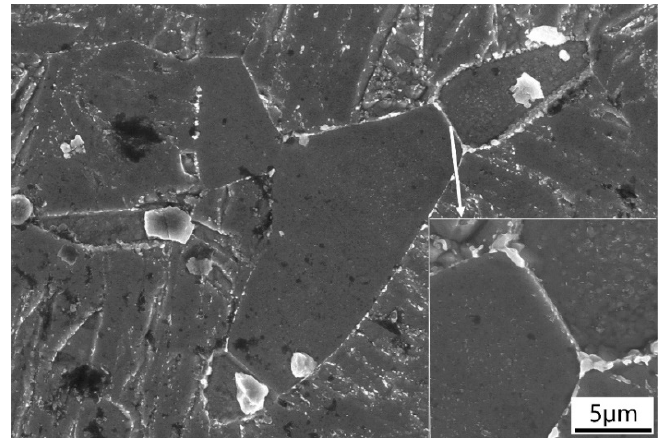
Figure 5. SEM image of δ -ferrite in 2# steel.